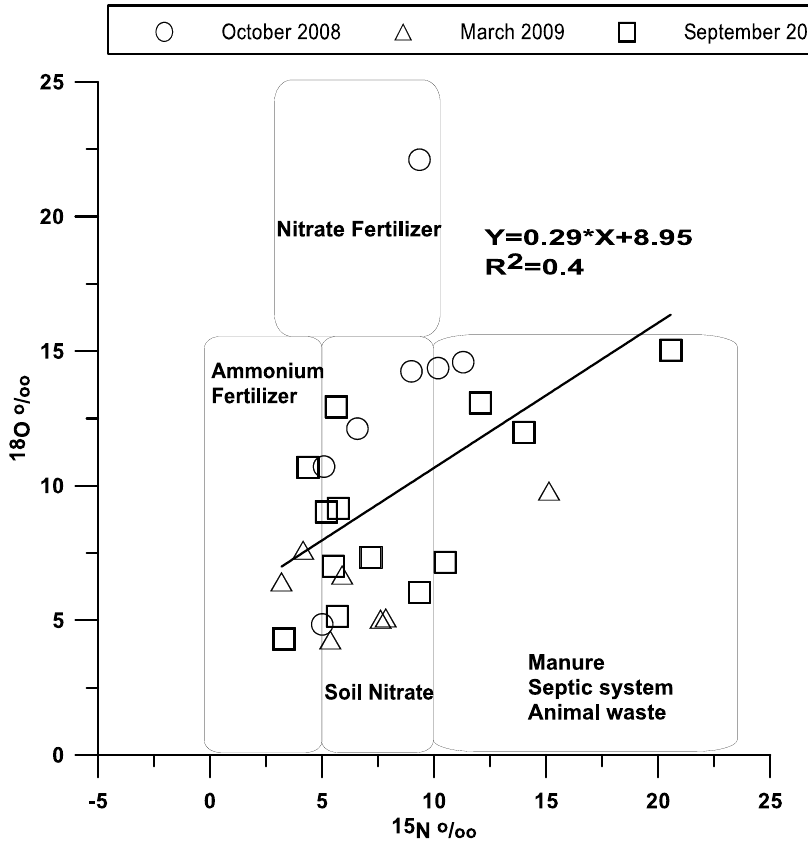
Figure 4. Ranges of nitrogen and oxygen isotopic composition for nitrate ‐ nitrogen sources. The domain of soil nitrate is shaded (dark) and manure sources and ammonium fertilizers (lightest). The long line represents a denitrification vector, as denitrification progresses, the nitrogen and oxygen isotopic values of the remaining nitrate progressively increase in the direction of the vector (Kendall and McDonnell, 1998).